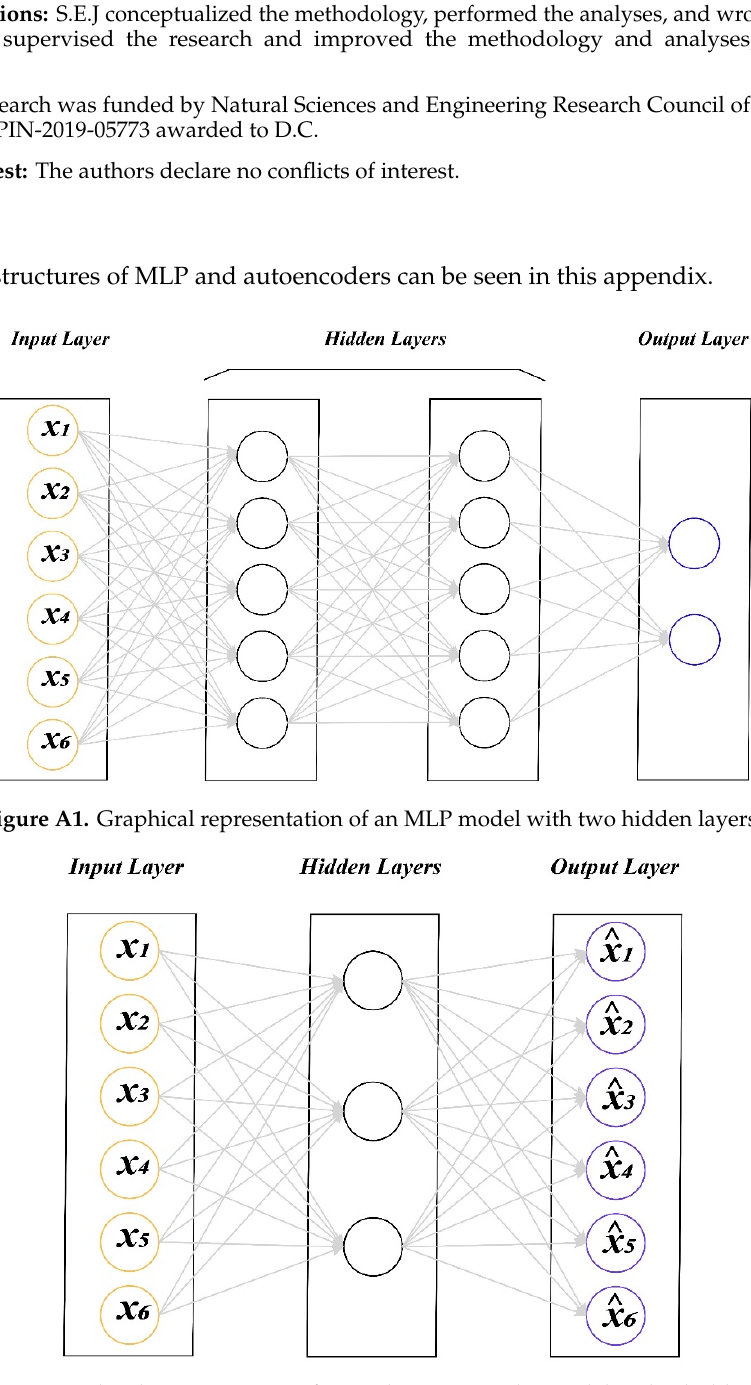
Figure A2. Graphical representation of a regular autoencoder model with a hidden layer.